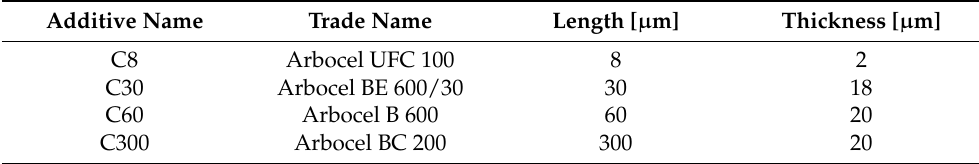
Table 1. The trade names, average fibre lengths and thicknesses of the applied cellulose fibres. The sample names were given based on their average lengths.